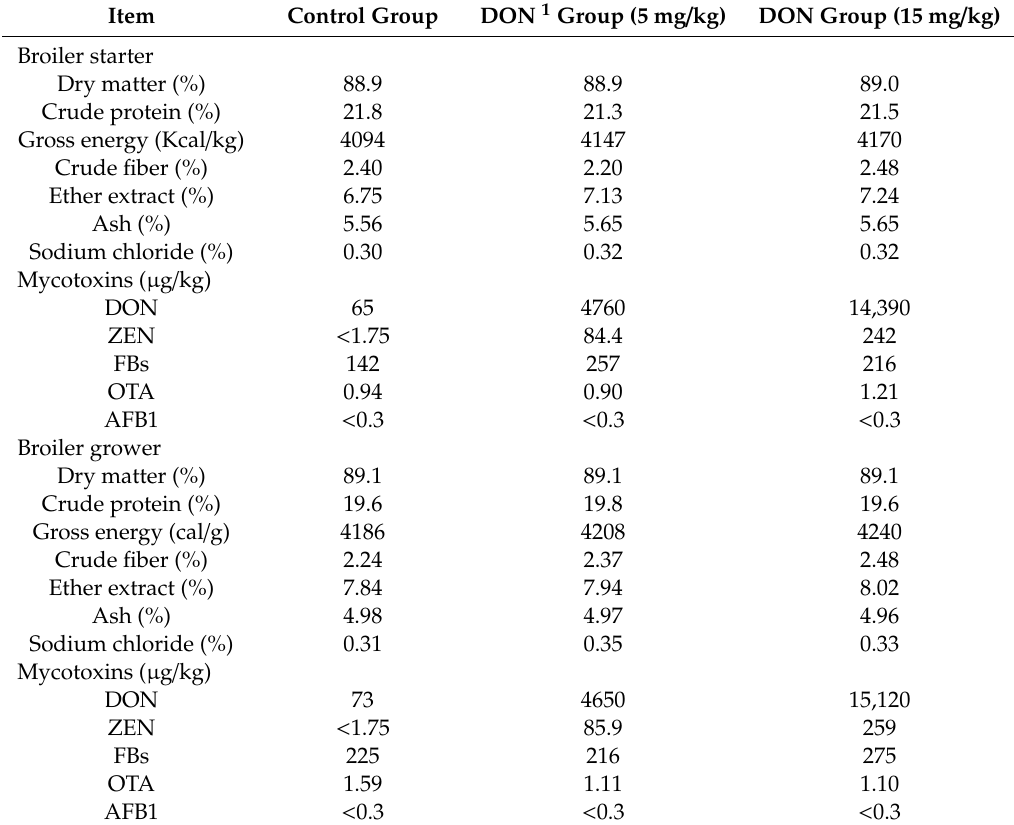
Table 1. Analyzed composition and mycotoxin contamination of the experimental diet. Control Group DON 1 Group (5 mg /